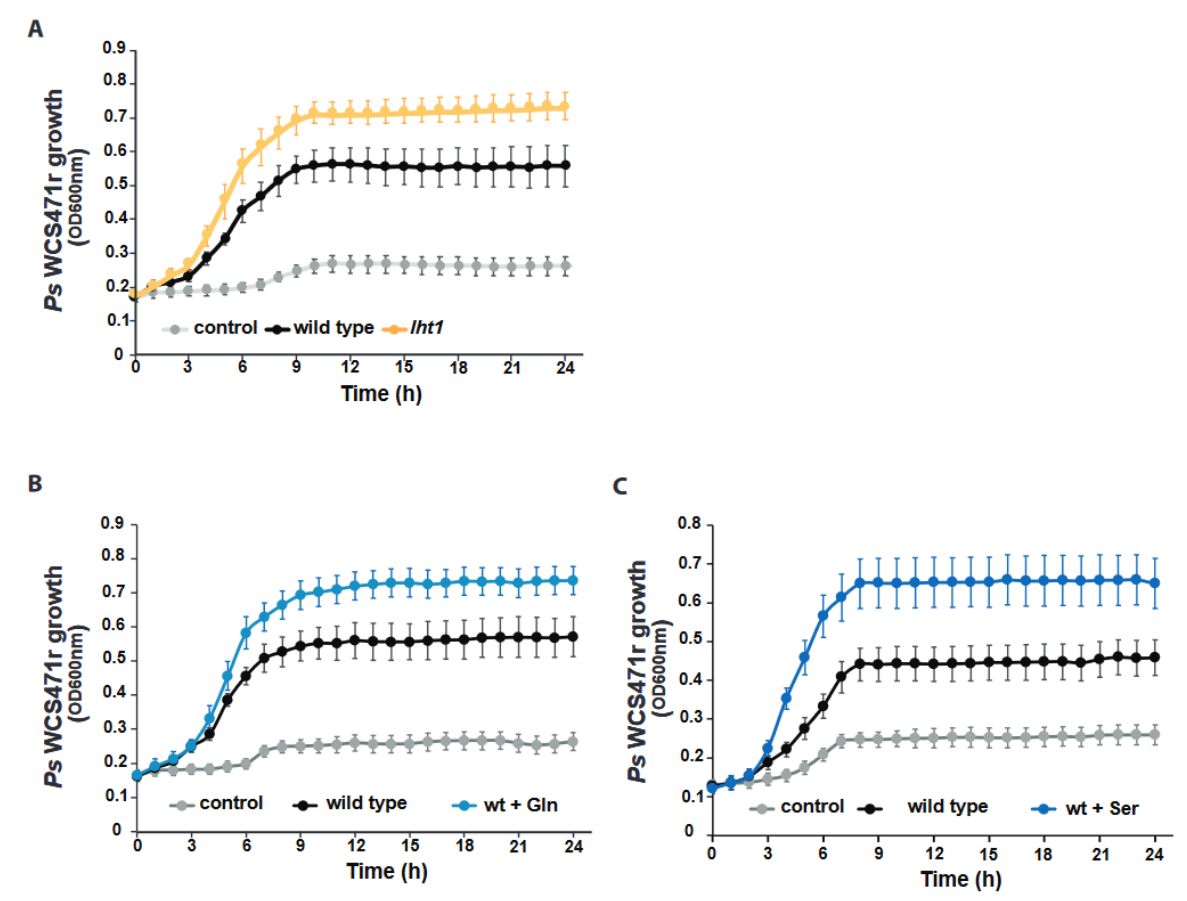
Figure 2. The lht1 -derived root exudates enhance Ps WCS417r growth. Across all panels in this fig- ure, data represent 3 independent biological replicates. Exudates were obtained, as described in Figure 1A and Methods. In each biological replicate, at least 6 wells per condition were seeded with exudates or control media and longitudinally scored for growth every hour using OD 600nm as the readout. Plates were incubated and scored in a temperature-controlled plate reader with shaking. Control corresponds to MS medium without exudate. Each dot in the curves represents the median growth of 6 wells at a given time point. Error bars are SEM. Statistical analysis was performed using the CGGC (comparison of groups of growth curves) permutation test to compare pairs of samples (e.g., wild type vs. lht1 ) over the course of growth (24 h). All differences between conditions were statistically significant. Further experimental and analysis details are described in the Methods sec- tion. ( A ) Ps WCS417r grows better in lht1 -derived than WT exudates. ( B ) Ps WCS417r grows better in Gln-supplemented WT exudates. WT exudates were supplemented with 1 mM Gln (final concen- tration) or an equal volume of water as control. ( C ) Ps WCS417r grows better in Ser-supplemented WT exudates. WT exudates were supplemented with 1 mM Ser (final concentration) or an equal volume of water as control. 2.3. Loss of LHT1 Promotes Root Colonization by Ps WCS417r Having uncovered that lht1 root exudates promote more Ps WCS417r growth, the next question to address was whether this enhanced in vitro growth would translate to better root colonization. To this end, Arabidopsis seedlings were grown for two weeks in MS-PhytoAgar plates incubated vertically and then transferred to sterile plates with au- toclaved 3 MM paper as the substrate (Figure S2A,B). One day later, roots were flood- inoculated with Ps WCS417r. After inoculation, the plates were incubated horizontally, and root colonization proceeded for 72 h. At that time, roots were weighed and processed